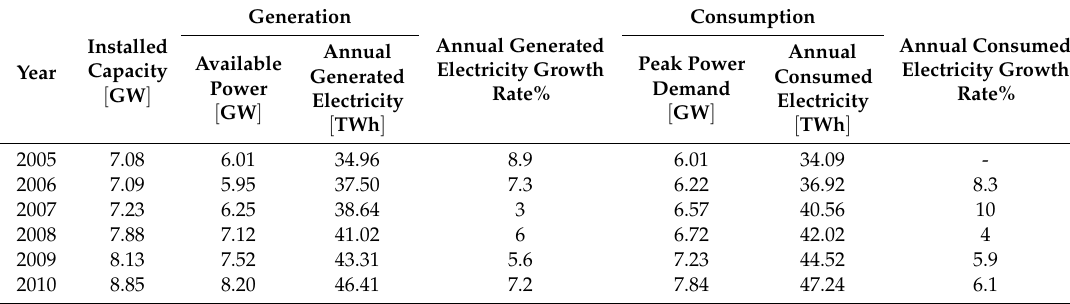
Table 2. Installed capacity, available power, generated energy, peak demand, and consumed energy of the SEPS in the period